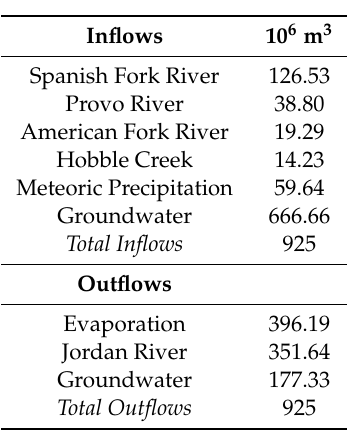
Table 4. Water budget for Utah Lake during the period April to November 2015. The outflow in the Jordan River is a minimum estimate (data from [64]) and the groundwater outflow is a maximum